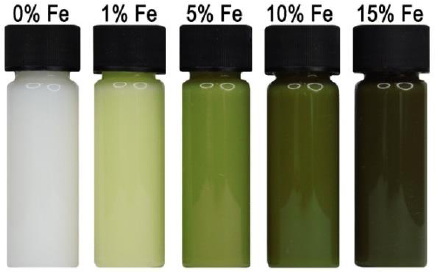
Figure 45. Visual comparison of changes in colours of suspensions of Zn 1− x Fe x O NPs depending on the dopant content. Source: own test results.